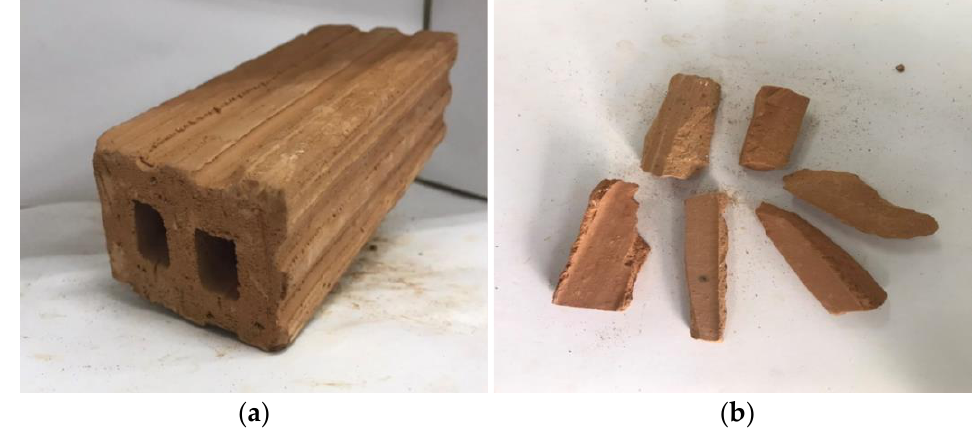
Figure 3. ( a ) Fired-clay interlocking bricks and ( b ) aggregate obtained from fired-clay interlocking bricks.